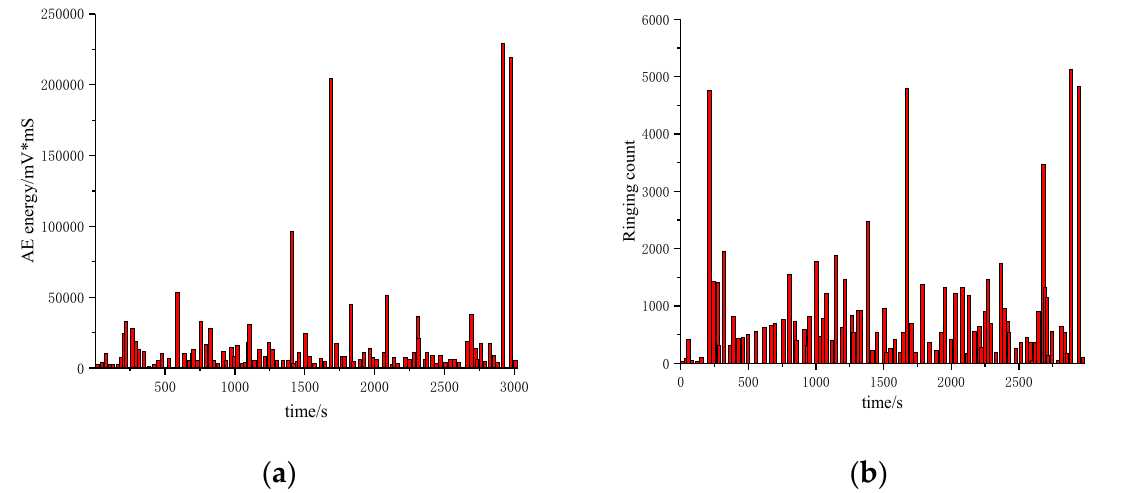
Figure 7. Acoustic emission acquisition results: ( a ) Acoustic emission energy; ( b ) Ringing count.